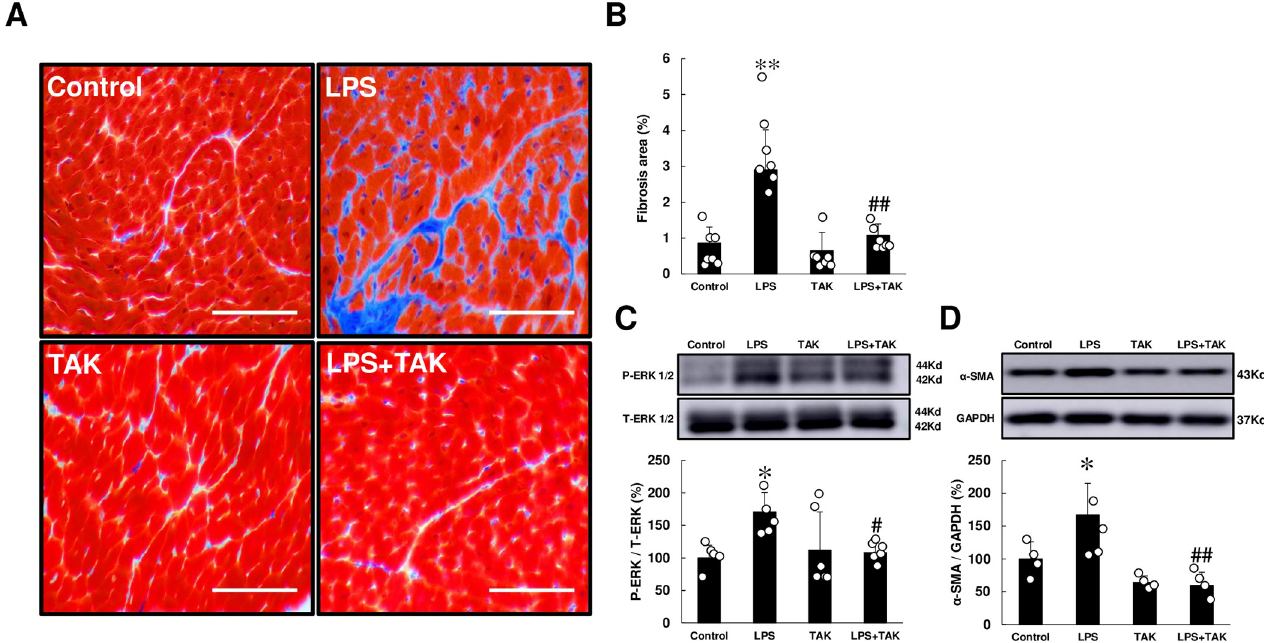
Fig 2. Effects of chronic PG-LPS infusion on fibrosis in cardiac muscle. (A) Representative images of Masson-trichrome-stained sections of cardiac muscle in the Control ( upper left ), PG-LPS (LPS) ( upper right ), TAK-242 (TAK) ( lower left ) and PG-LPS + TAK-242 (LPS + TAK) ( lower right ) groups. Scale bars: 50 μ m . (B) The area of fibrosis was significantly increased in the PG-LPS group ( P < 0.01 vs. Control), and this increase was significantly attenuated by TAK- 242. �� P < 0.01 vs. Control or ## P < 0.01 vs. PG-LPS group by one-way ANOVA followed by the Tukey-Kramer post hoc test. (C) Expression of phospho- ERK1/2 (Thr-202/Tyr-204) (C) and α -SMA (D) was significantly increased in cardiac muscle of PG-LPS-treated mice, and these increases were significantly attenuated by TAK-242. � P < 0.05 vs. Control, # P < 0.05 vs. PG-LPS group or ## P < 0.01 vs. PG-LPS group by one-way ANOVA followed by the Tukey- Kramer post hoc test. Full-size images of immunoblots are presented in S3 and S4 Figs of S1 Data . Data shows means ± SD and scattered dots show individual data.